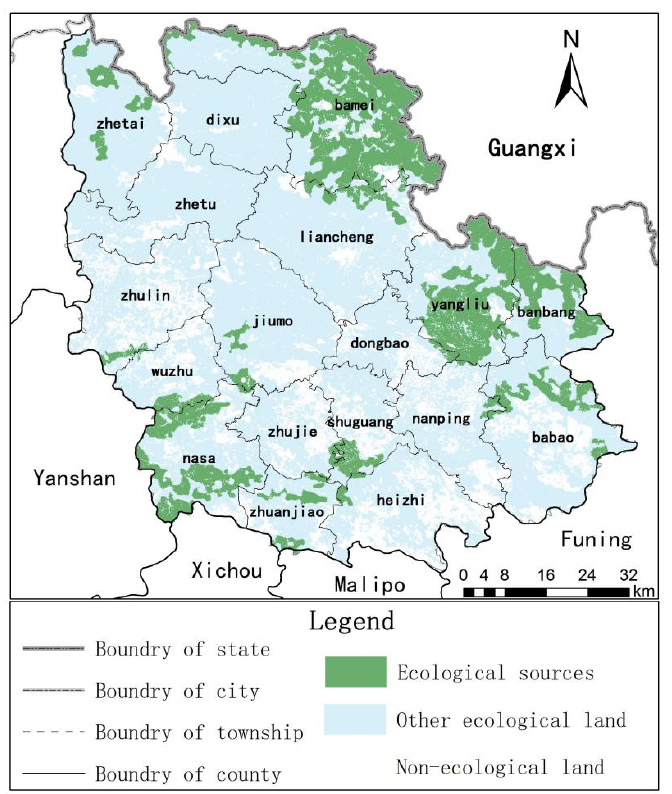
Figure 5. Spatial distribution of ecological sources.